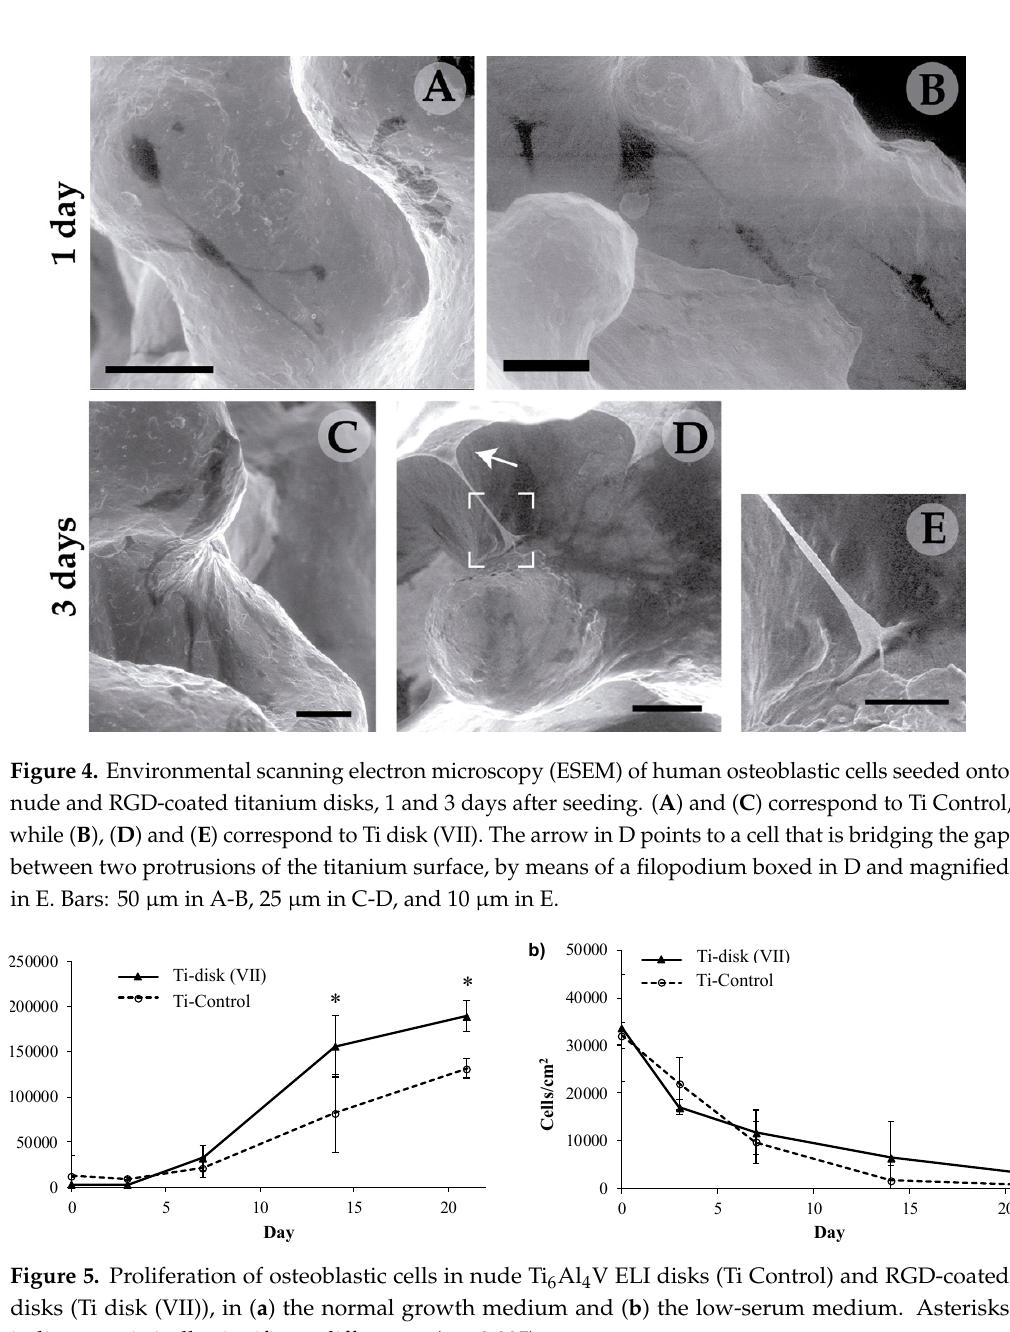
Figure 5. Proliferation of osteoblastic cells in nude Ti 6 Al 4 V ELI disks (Ti Control) and RGD-coated disks (Ti disk (VII)), in ( a ) the normal growth medium and ( b ) the low-serum medium. Asterisks indicate statistically significant differences (p < 0.005).